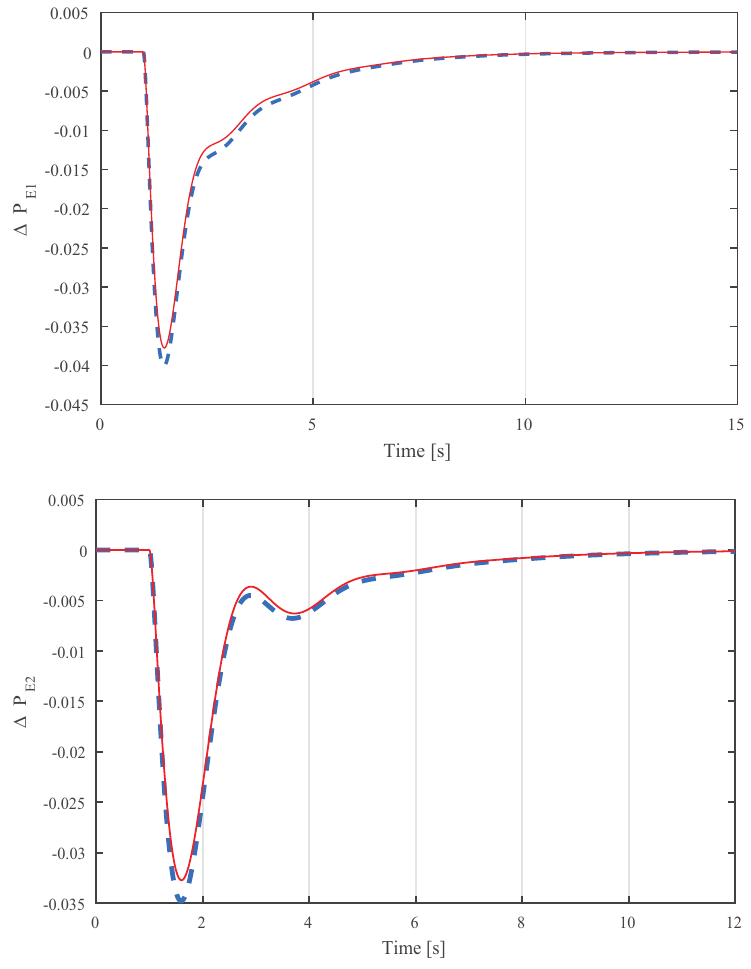
Figure 11. The Compared responding curves of V2G system subjected to SOC(solid: proposed, dashed: 0.8 multiples).